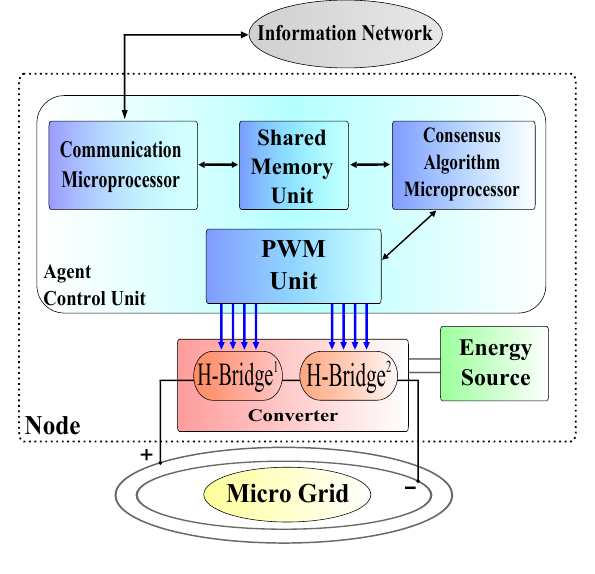
agent, respectively. Furthermore, there is a third parameter RAM Memory Slot (nslot) representing the number of information packets stored inside the SMU, both in Input or Output direction, i.e. a bu ff er